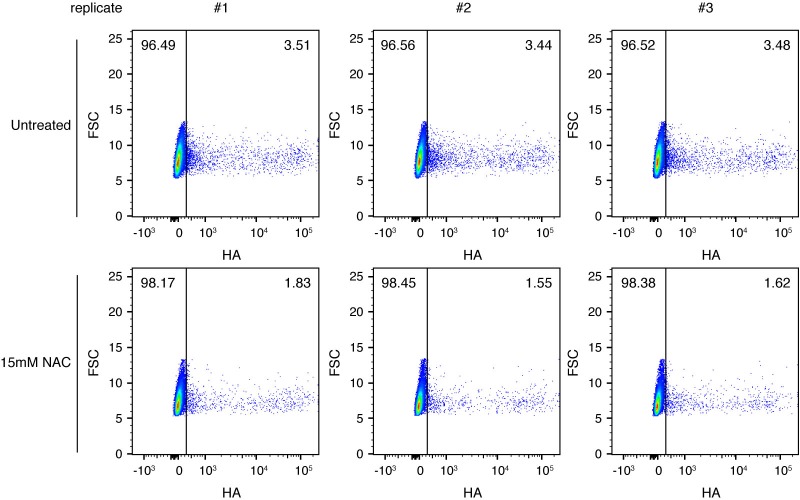
Pre-treating to reduce oxidative stress decreases the fraction of infected cells expressing detectable viral protein.Cells were treated as indicated with 15 mM N-acetylcysteine (NAC), an antioxidant, and infected at an MOI of 0.1 as calculated by TCID50 on MDCK-SIAT1 cells. At 10 hr post-infection, cells were analyzed by flow cytometry for HA expression. The percentage of HA-positive cells is indicated on the flow cytometry plots. Data are shown for three independent replicates.